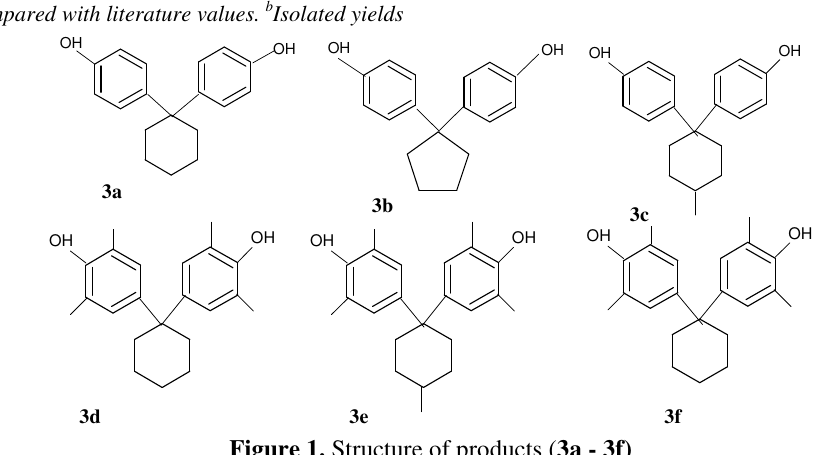
Figure 1. Structure of products ( 3a -